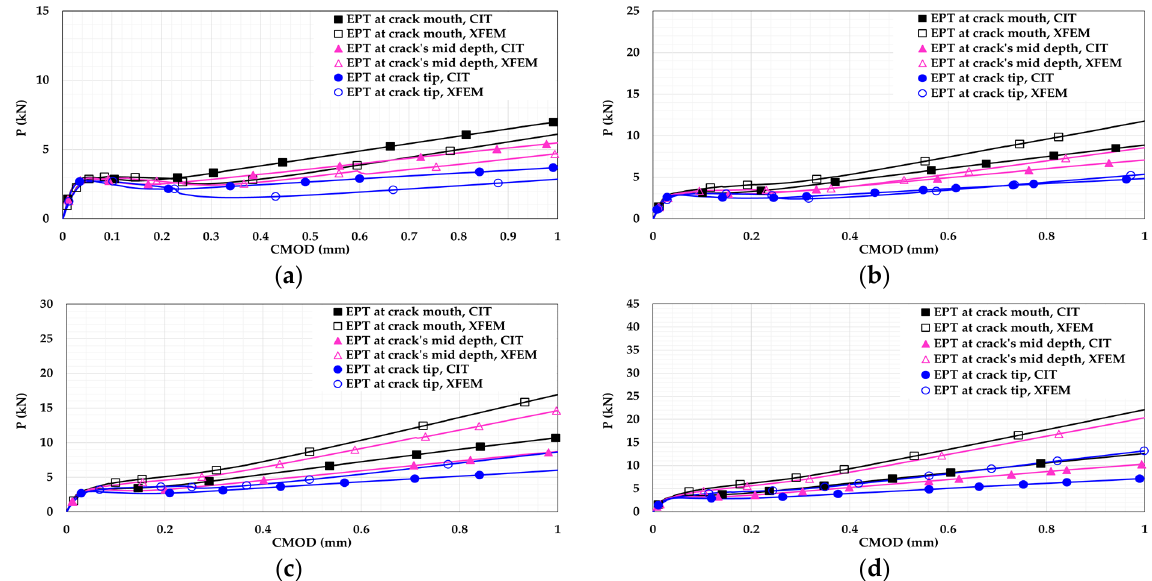
Figure 12. Plain concrete beam P-CMOD relationships for different EPTs at different locations: ( a ) 0%; ( b ) 25%; ( c ) 50%; ( d ) 75%.